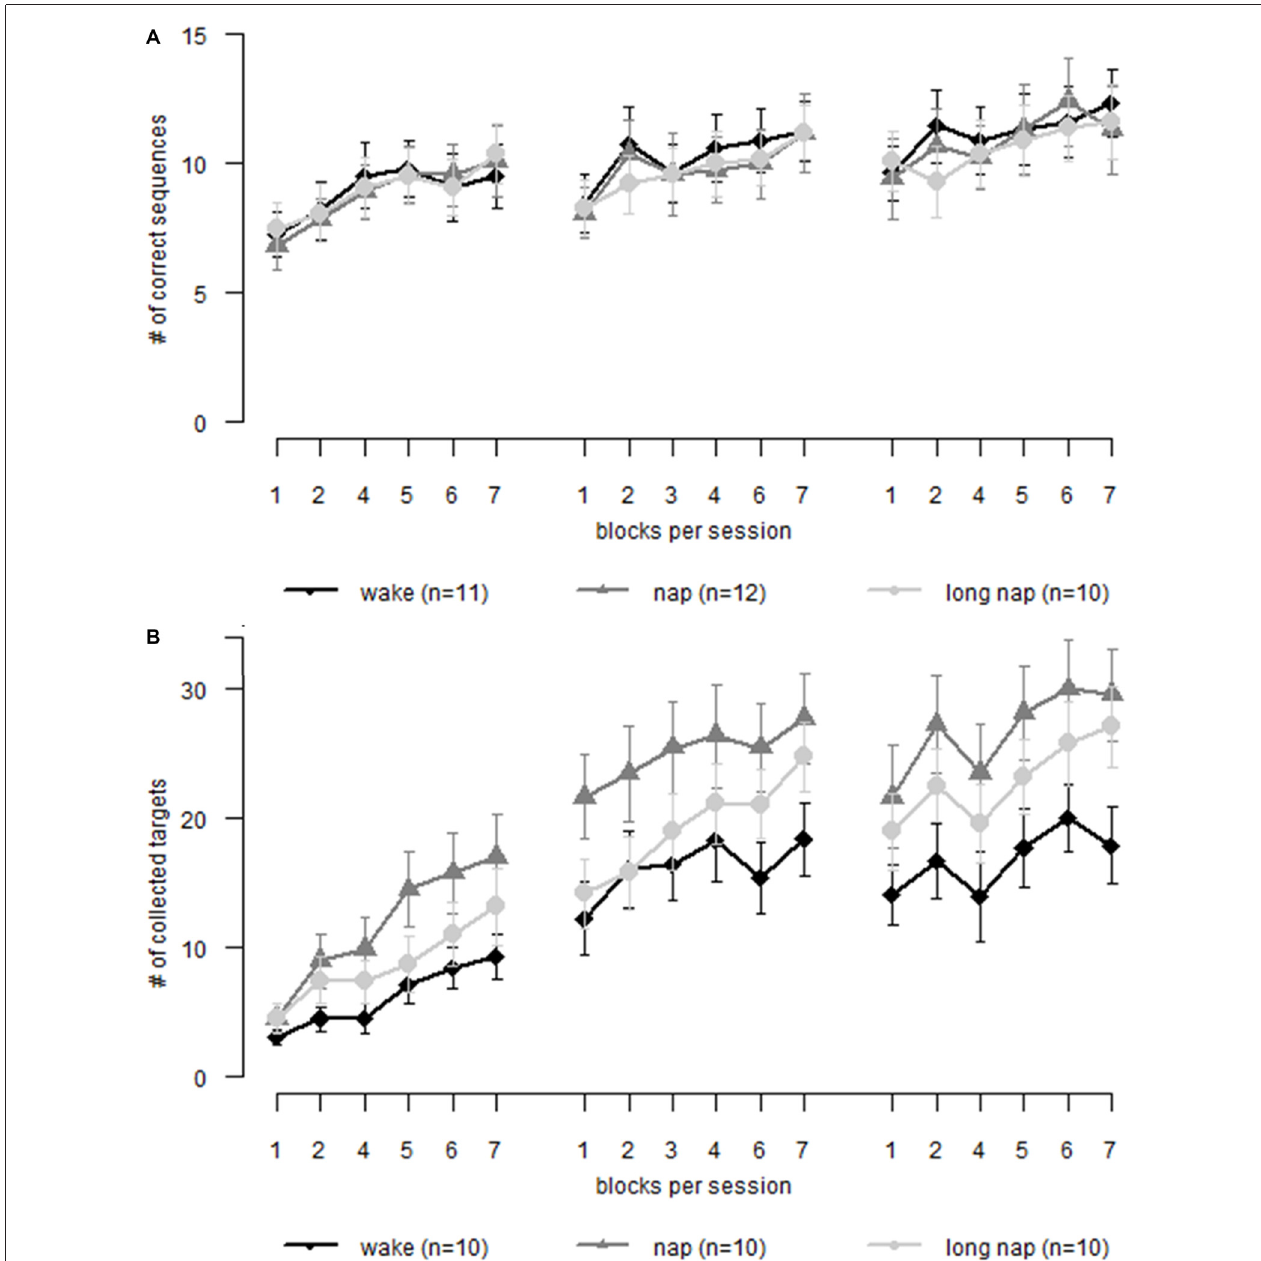
FIGURE 5 | Motor learning in older adults. Each graph displays learning during three sessions. Session 1 and 2 are interleaved by a nap or wakefulness, depending on group allocation. Session 2 and 3 is separated by night sleep. (A) Sequence learning (B) motor adaptation. Error bars represent the standard error of the